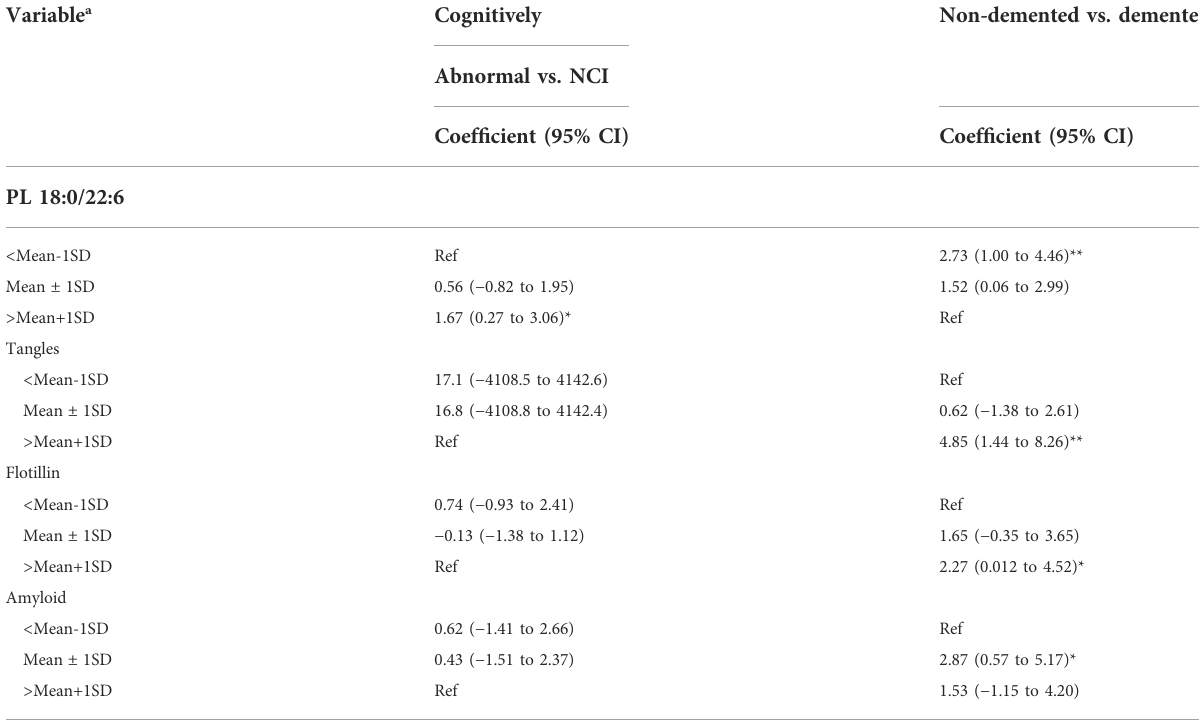
TABLE 5 Association of low, medium and high levels of PL 18:0/22:6, amyloid, tangles and fl otillin with normal cognition and Dementia. Variable a Cognitively Non-demented vs.